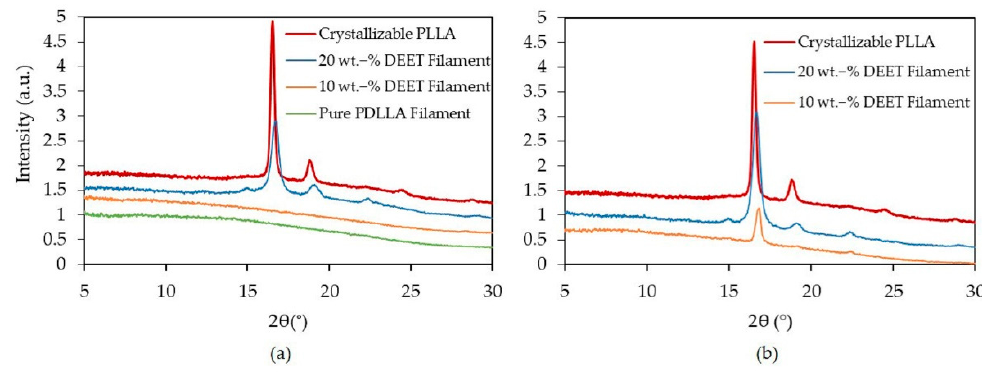
Figure 7. XRD-scans of PDLLA monofilaments with varying DEET content ( a ) after spinning and ( b ) after additional subsequent annealing at 80 °C for 1 h.